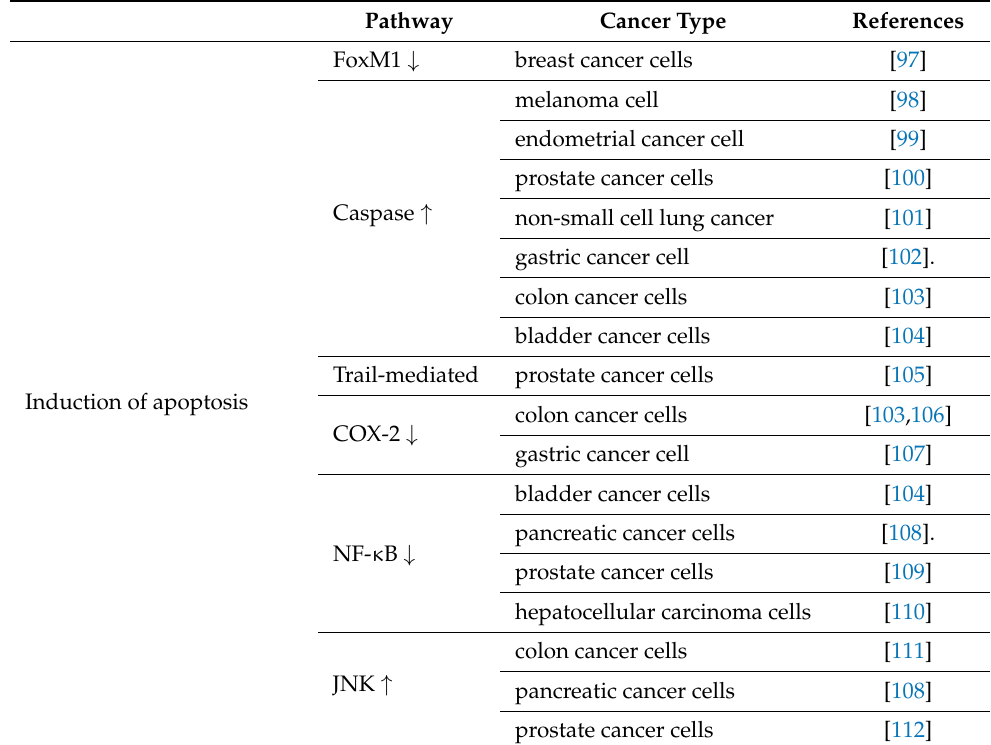
Table 2. Anti-cancer effects of